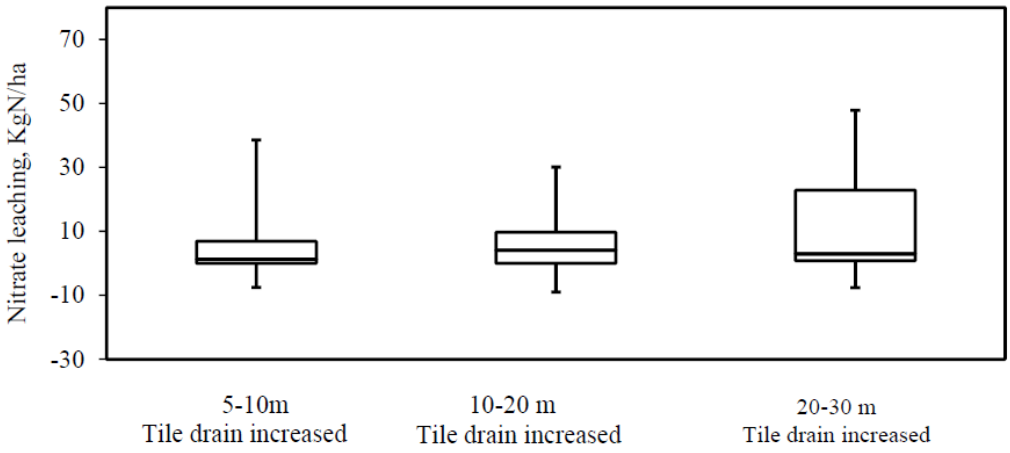
Figure 13. Figure showing mean nitrate leaching are not sensitive to the increased tile drain space in rotated corn (two journal articles were considered for analysis).